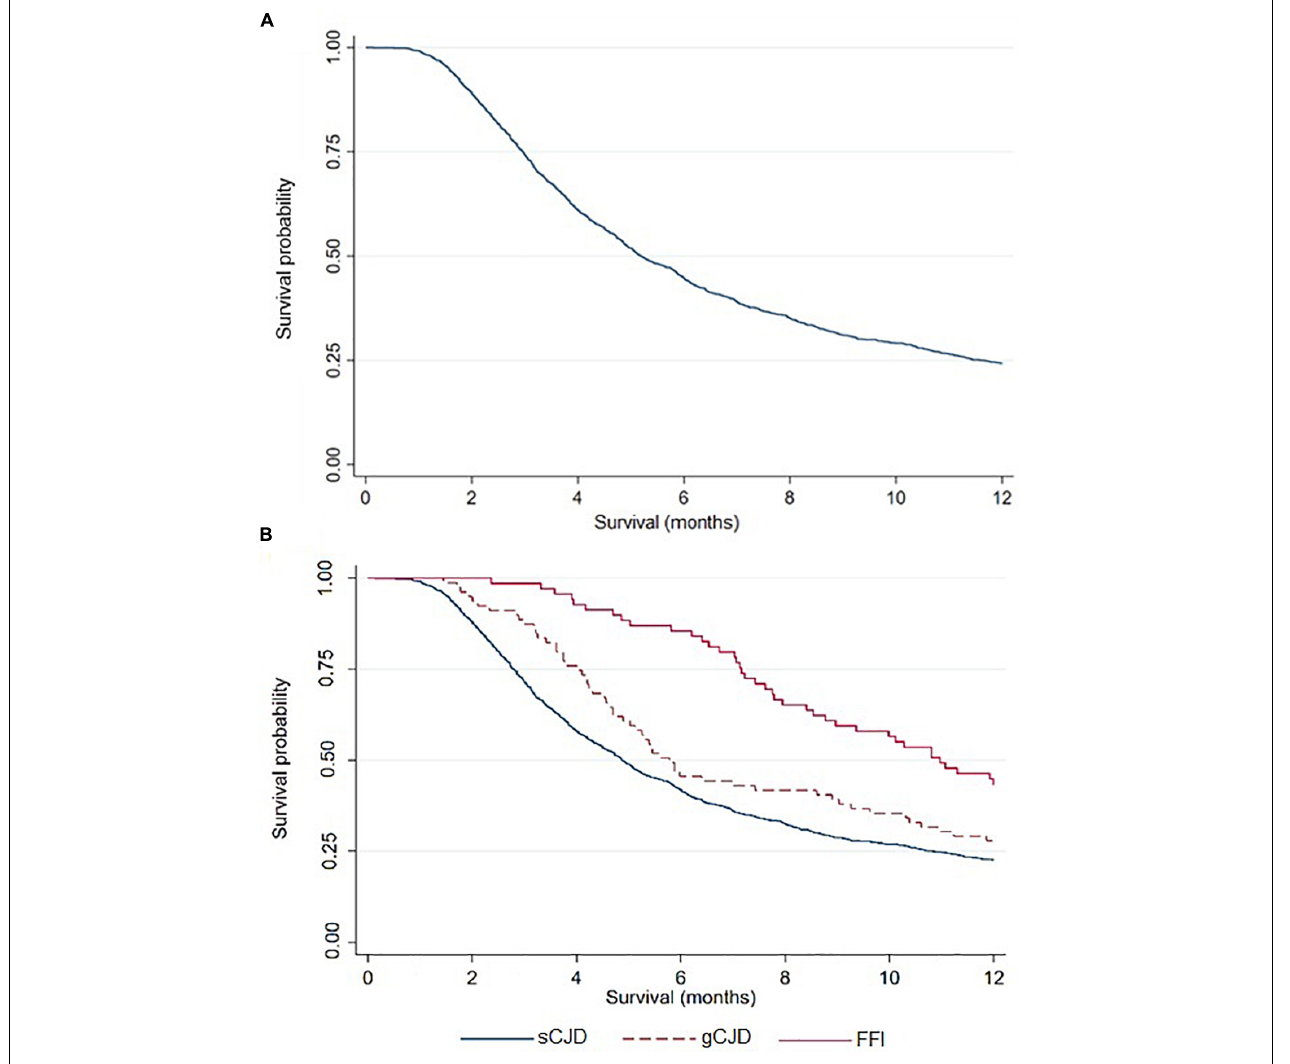
FIGURE 2 | TSE Survival curve, overall (A) and by type (B) , using the Kaplan-Meier method.